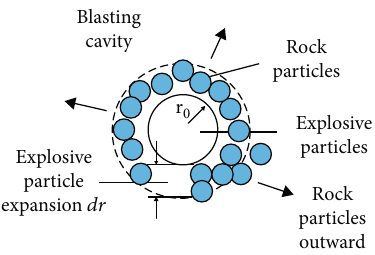
Figure 1: Schematic showing the impact of a spherical charge